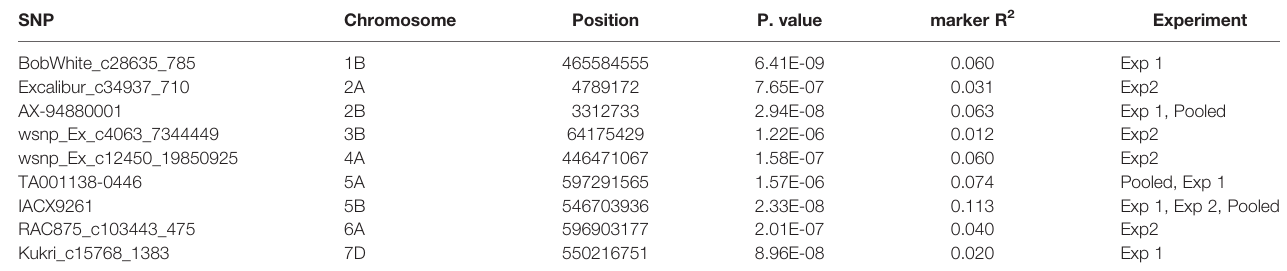
TABLE 2 | Markers signi fi cantly associated with seedling resistance to tan spot through FarmCPU model. SNP